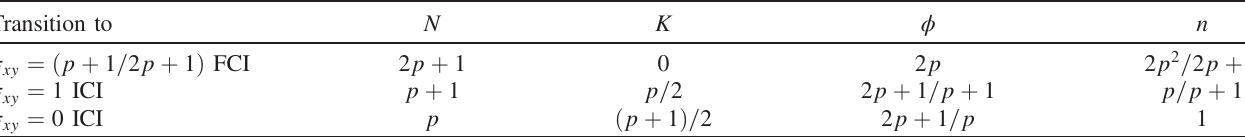
TABLE I. The summary of interesting sequences of transitions. We consider a transition from a ν ¼ p= ð 2 p þ 1 Þ FQH state to a FCI or CI state. We take a simple square lattice potential in Eq. (8), and each unit cell has the flux density ϕ and the particle density n . The multiflavor Dirac fermions are protected by the magnetic translation symmetry of composite fermions. Transition to N K